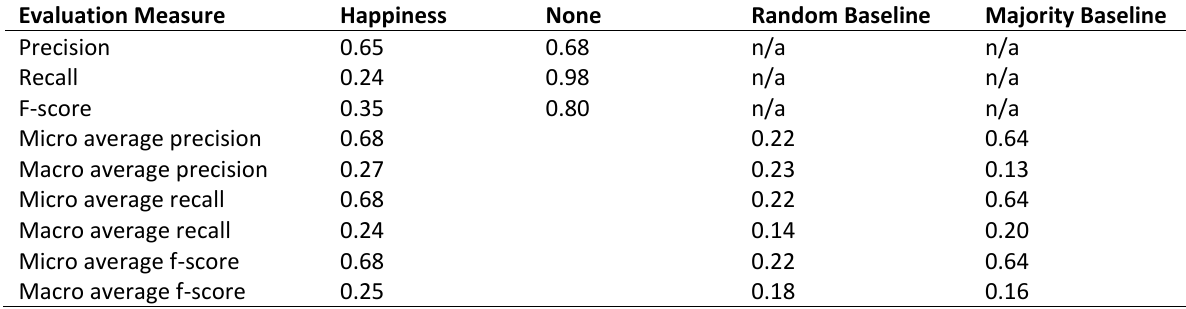
Figure 3. Spatial distribution and density of the tweets labelled with “happiness” (left) and “none” (right). Table 3. Statistical evaluation